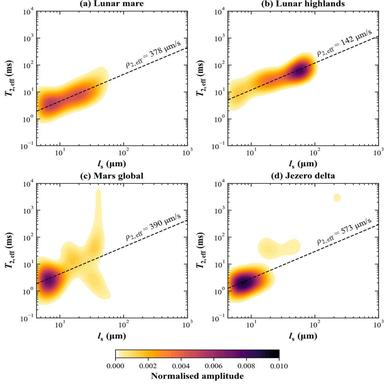
T2,eff-ls distributions as determined by DDIF-CPMG measurements. Measurements are conducted on fully saturated samples, for: (a) Lunar Mare, (b) Lunar highlands, (c) Mars global and (d) Jezero delta simulants. Dashed lines indicate the average effective surface relaxivity of the distributions.